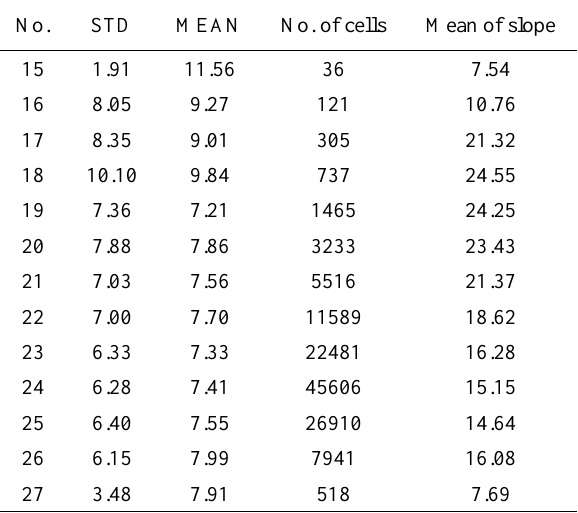
Table 1. The calculated parameters for Bomehen study area